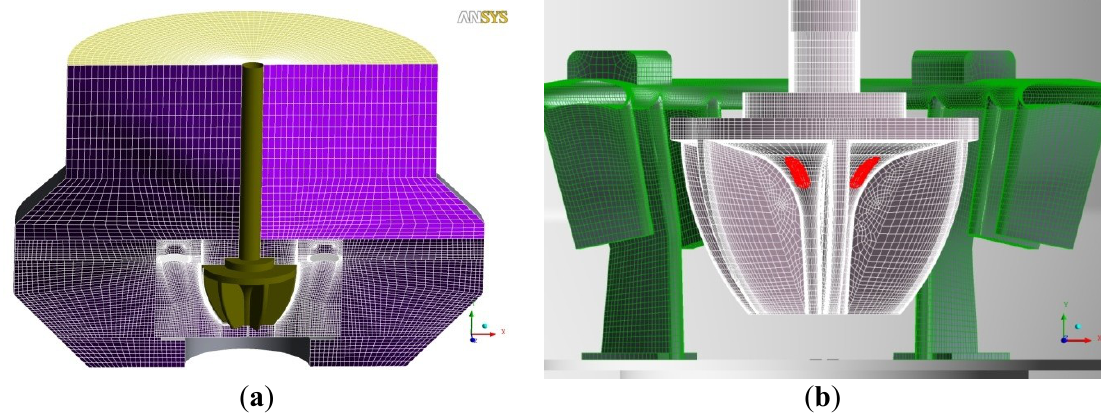
Figure 2. ( a ) Block structured mesh and ( b ) surface grids on rotor and stator